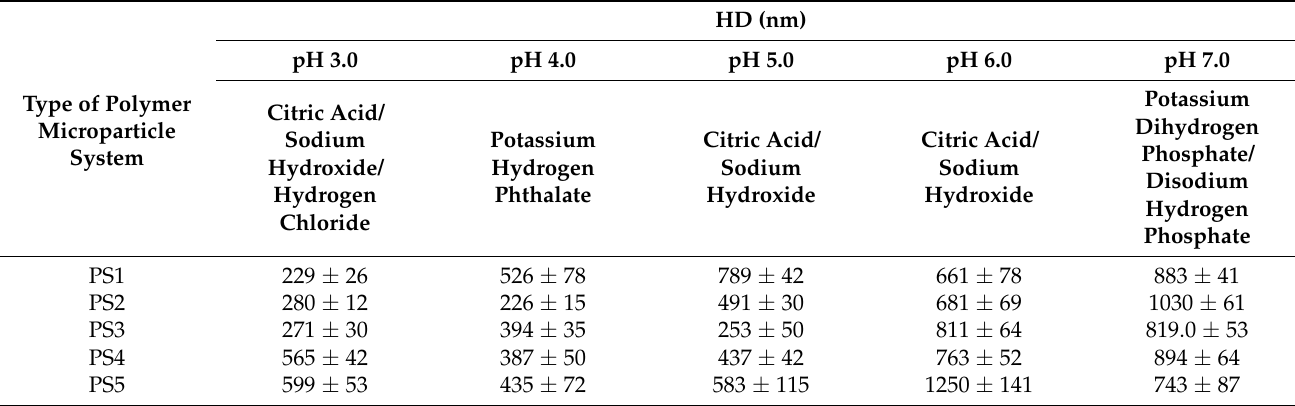
Table 2. The values of hydrodynamic diameters (HD) of PS1, PS2, PS3, PS4, and PS5 samples in buffers at pH 3.0, 4.0, 5.0, 6.0, and